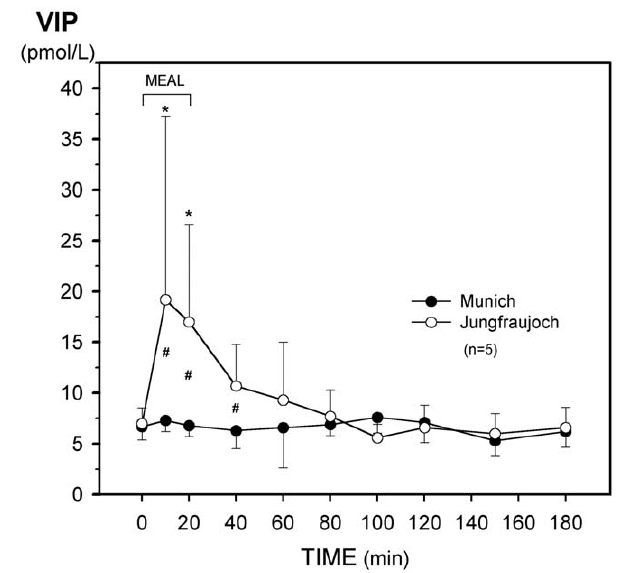
Figure 5. Effect of acute exposure to high altitude (Munich, 490 m, to Jungfraujoch, 3454 m) on postprandial plasma levels of vasoactive intestinal peptide (VIP). Asterisks (*) indicate a significant increase (p , 0.03) as compared with the preprandial values at 0 min and crosses ( # ) mean a significant (p , 0.03) difference between the respective values at the two sea levels.